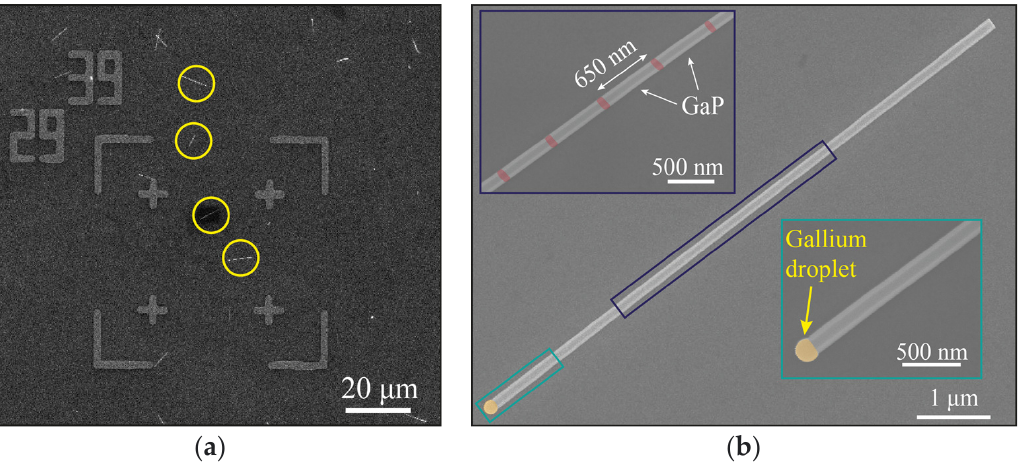
Figure 2. ( a ) SEM image of the marked glass wafer with the drop-casted NWs highlighted with yellow circles, and ( b ) SEM image of individual GaP/GaP x As 1 − x NW heterostructure; the insets show the enlarged views of the segments with GaP x As 1 − x NDs (red colored) and Ga droplet.